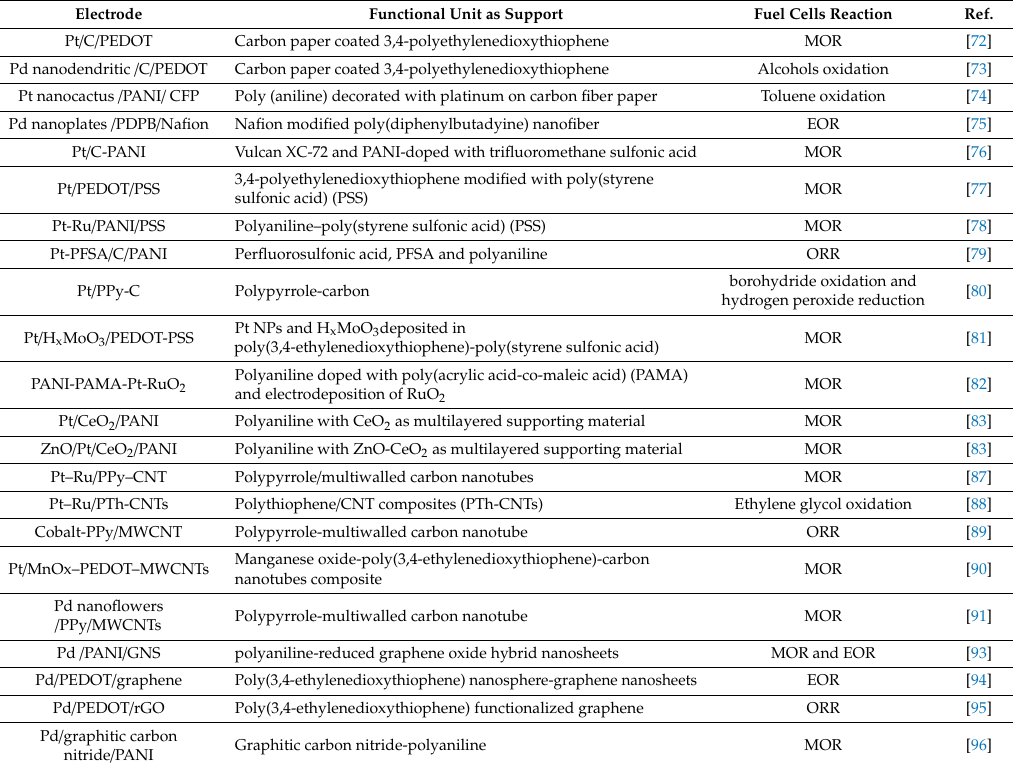
Table 2. List of the functionalized conducting polymer-supportedmetal electrocatalysts for fuel cell applications. Electrode Functional Unit as Support Fuel Cells Reaction